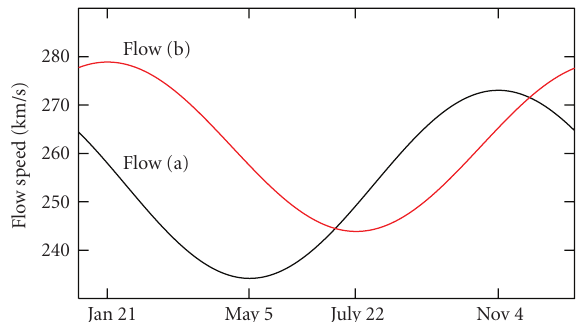
Figure 3: Speed of the two caustic flows relative to the earth. Flow (a) peaks in November, and is smallest in May. Flow (b) peaks in January, and is smallest in